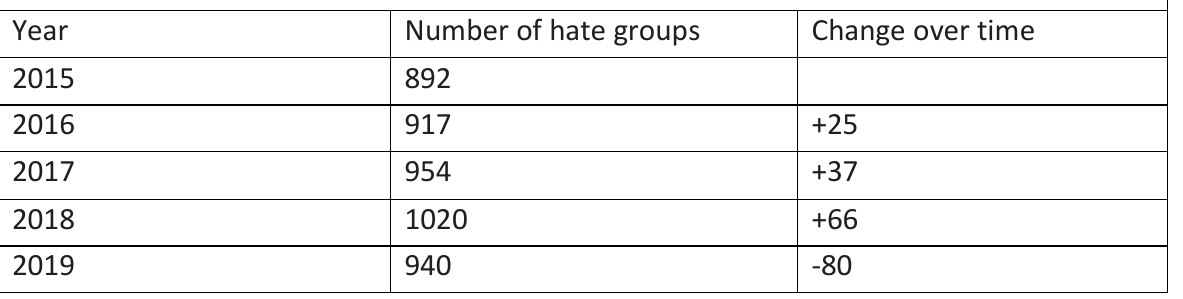
Table 1: Hate Groups in the United States Hate Groups in the United States monitored by the